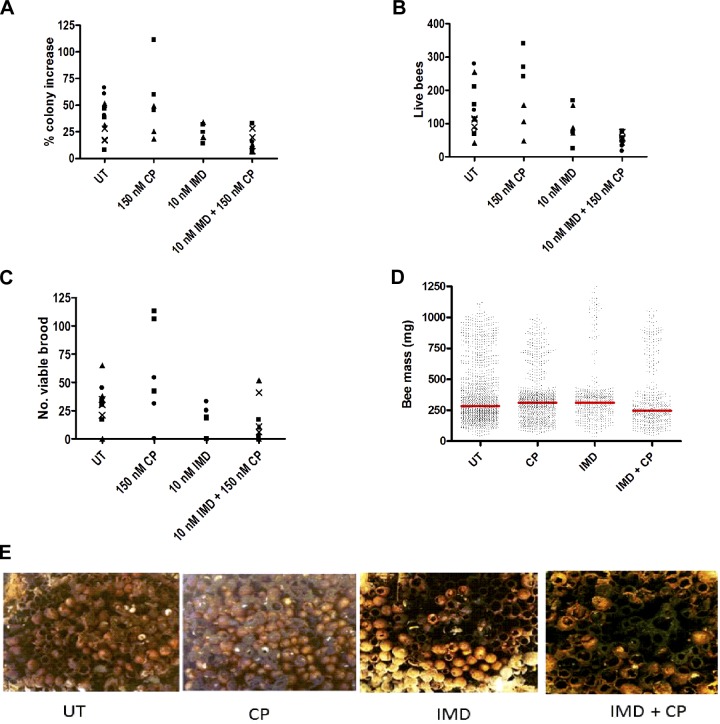
Exposure of bumblebee colonies to field-relevant levels of imidacloprid decreases colony performance. Bumblebee colonies of similar mass were provided with sugar syrup (UT, n = 12), containing chlorpyrifos (CP, 150 nM, n = 6), imidacloprid (IMD, 10 nM, n = 6), or both (IMD + CP, n = 12). No pollen was provided, and bees were free to forage in a wilderness/grassland area in the west of Scotland. After 43–48 d in the field, colony performance indicators were monitored. Nests within each box are depicted with the same symbol. A) Percentage colony mass increase for each nest. B) Total number of live bees remaining in each nest. C) Number of viable brood cells on the outer face of each nest. D) Size distribution scatter of individual bee masses within each treatment group. Median values are shown by red lines. E) To report on the condition of the nests, a representative image of each nest was collected. A representative example from each treatment group is illustrated (all images are available in Supplemental Fig. S2).